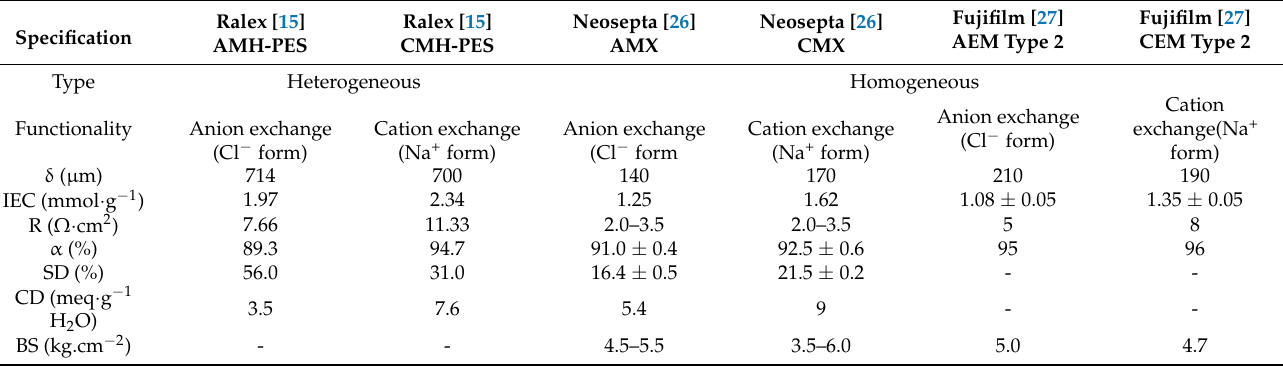
Table 3. The properties of ion exchange membranes used in RED tests.